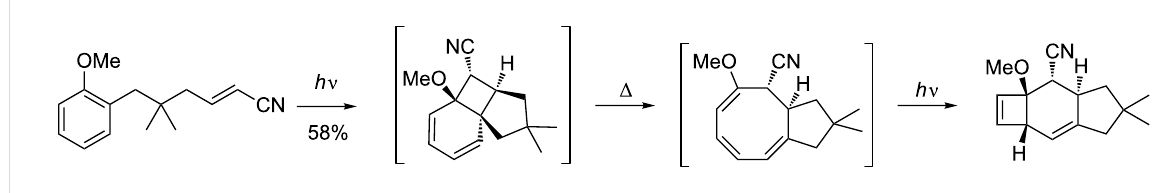
Scheme 25: Ortho photocycloaddition followed by rearrangements.